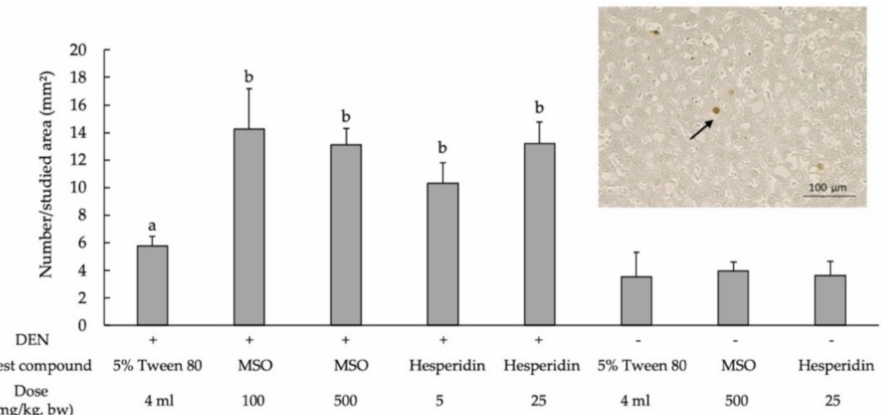
Figure 6. Effect of a 10-week administration of MSO and its compositions on apoptosis in the livers of rat. Black arrow; apoptotic hepatocytes. Values are expressed as mean ± SD. DEN: diethylni- trosamine; GST-P: glutathione S -transferase placental form; MSO: mixed sesame and orange seed extract; PCNA: proliferating cell nuclear antigen; a significantly different from a negative control group ( p < 0.05); b significantly different from a positive control group ( p < 0.05).